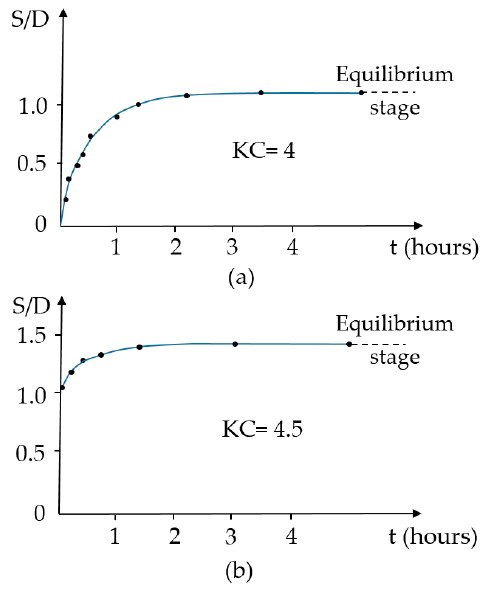
Figure 1. Illustration of time development of SD: ( a ) KC = 4; ( b ) KC = 4.5.